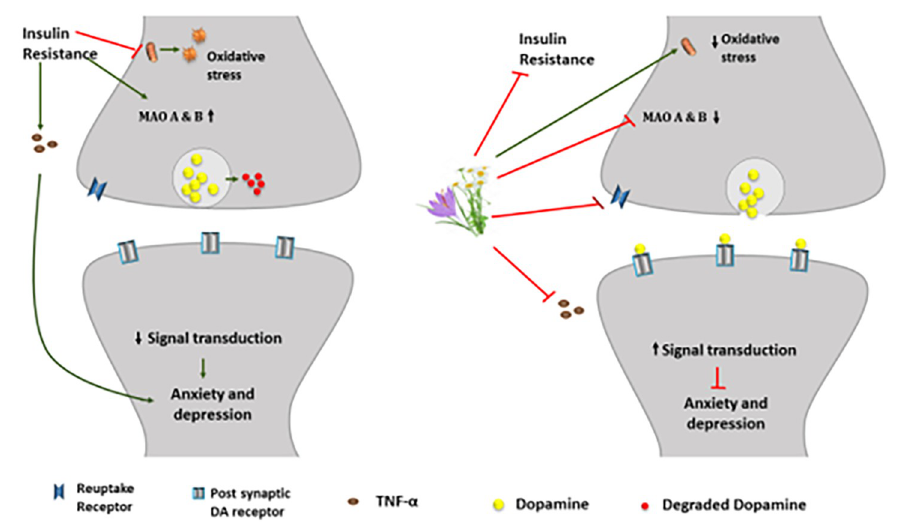
Fig 1. Schematic representation showing the possible mechanism by which herbal treatment (Saffron and Chamomile) play a role in the reduction of anxiety and depression.